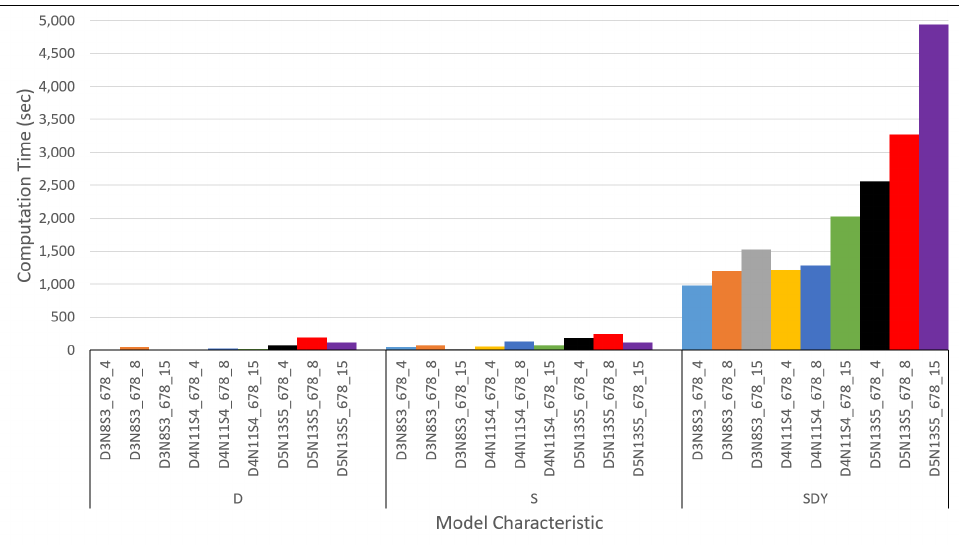
Figure A18. Computation Time for Maximum Road Capacity Setting ( 6,7,8 ) in Online and Offline Computation for all Instances grouped by Model